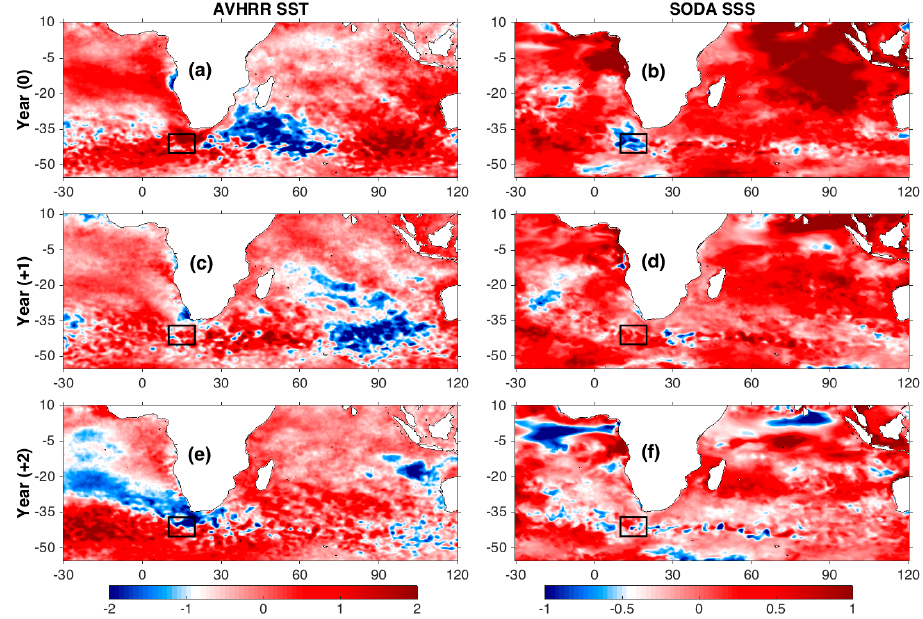
Figure 8. Composite mean for strong 1988–1989 La Niña minus the weak 2000–2001 La Niña from January–March for both AVHRR SST anomalies (right column) and SODA SSS anomalies (left column) during the peak ( a , b ), the following year ( c , d ), and two years after ( e , f ). The boxes represent the established leakage region (37°–45°S, 10°–20°E).